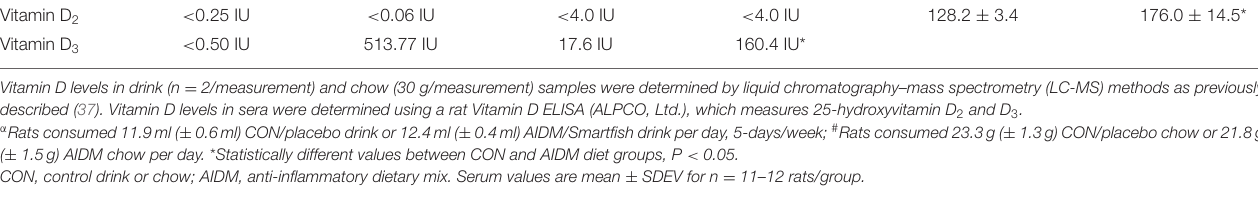
Frontiers in Nutrition |